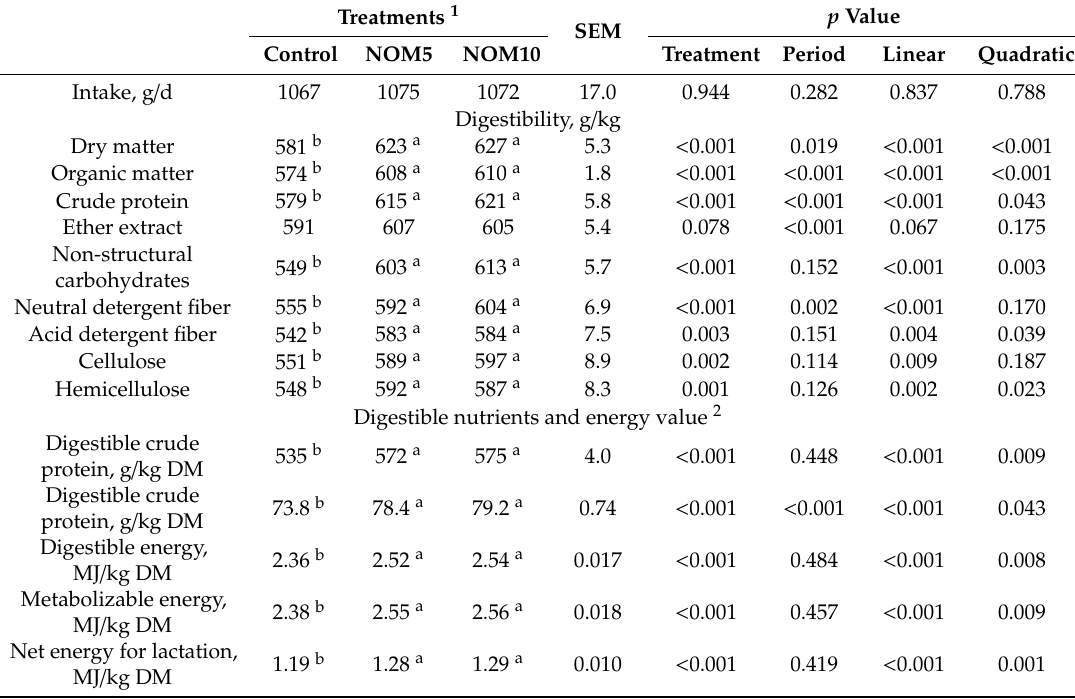
Table 5. Intake and nutrient digestibility of basal diet supplemented with N. oculata .